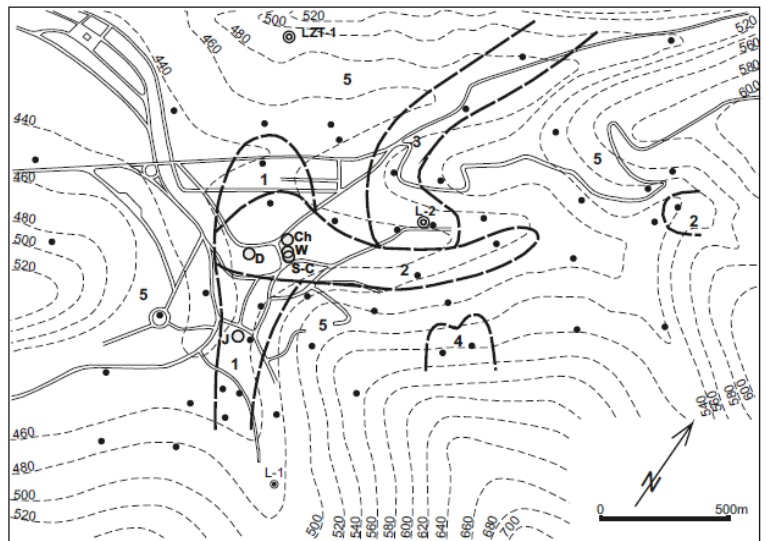
Figure 3. The hydrochemical anomaly of the Lądek-Zdrój area (based on [5]). Key—chemical types of waters: 1—Na-Ca-HCO 3 -SO 4 , 2—Na-HCO 3 -SO 4 , 3—Ca-Na-HCO 3 -SO 4 , 4—Ca-Na-HCO 3 -SO 4 , and 5—Ca-Na-SO 4 -HCO 3 ; spring designation: J—Jerzy, S-C—Skłodowska-Curie, W—Wojciech, Ch—Chrobry, and D—D ˛abr ó wka; boreholes: L-2, LZT-1; black points—shallow boreholes; dashed lines—borders between chemical types of waters determined on the basis of 50 shallow